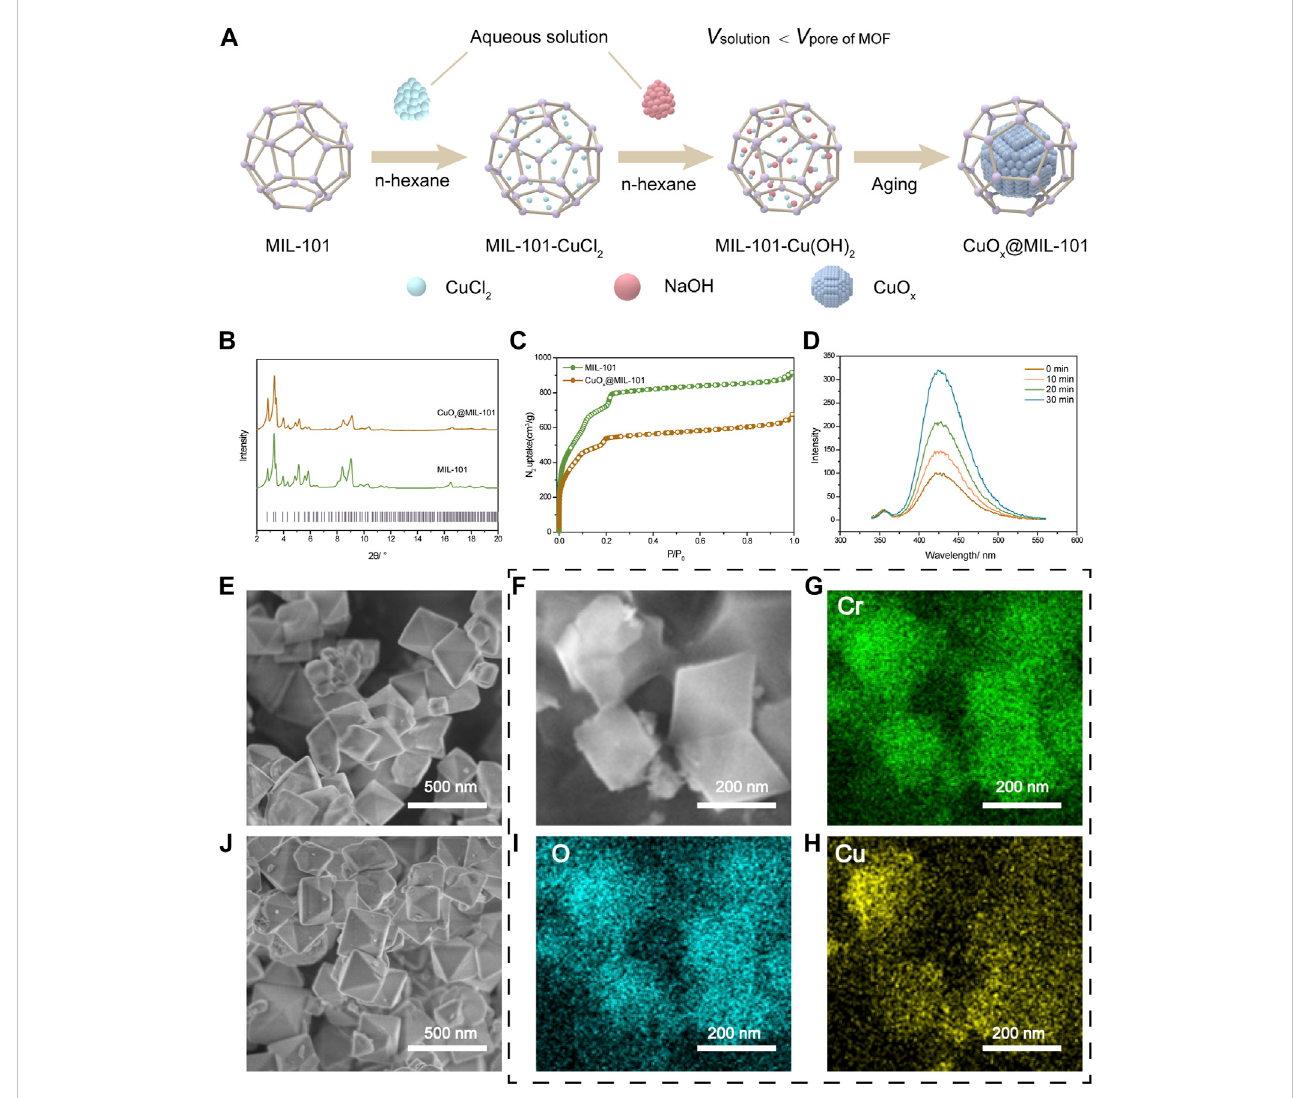
FIGURE 1 CuO X @MIL-101 nanoparticles characterization and its property of generating free radicals. (A) Schematic of the production of CuO X @MIL-101. (B) XRD X-raydiffraction(XRD)patternsofsimulatedMIL-101andCuO x @MIL-101 (C) N2isothermsofMIL-101andCuO x @MIL-101. (D) ROSproductionwasmeasured by the fl uorescence spectrophotometer. (E, J) SEM images of MIL-101 and CuO X @MIL-101 (scale bar = 500 nm). (F – H) Elemental mapping of a bright- fi eld scanning SEM images of the distributions of chromium (Cr), copper (Cu), and oxygen (O) within the MIL-101 crystals (scale bar = 200